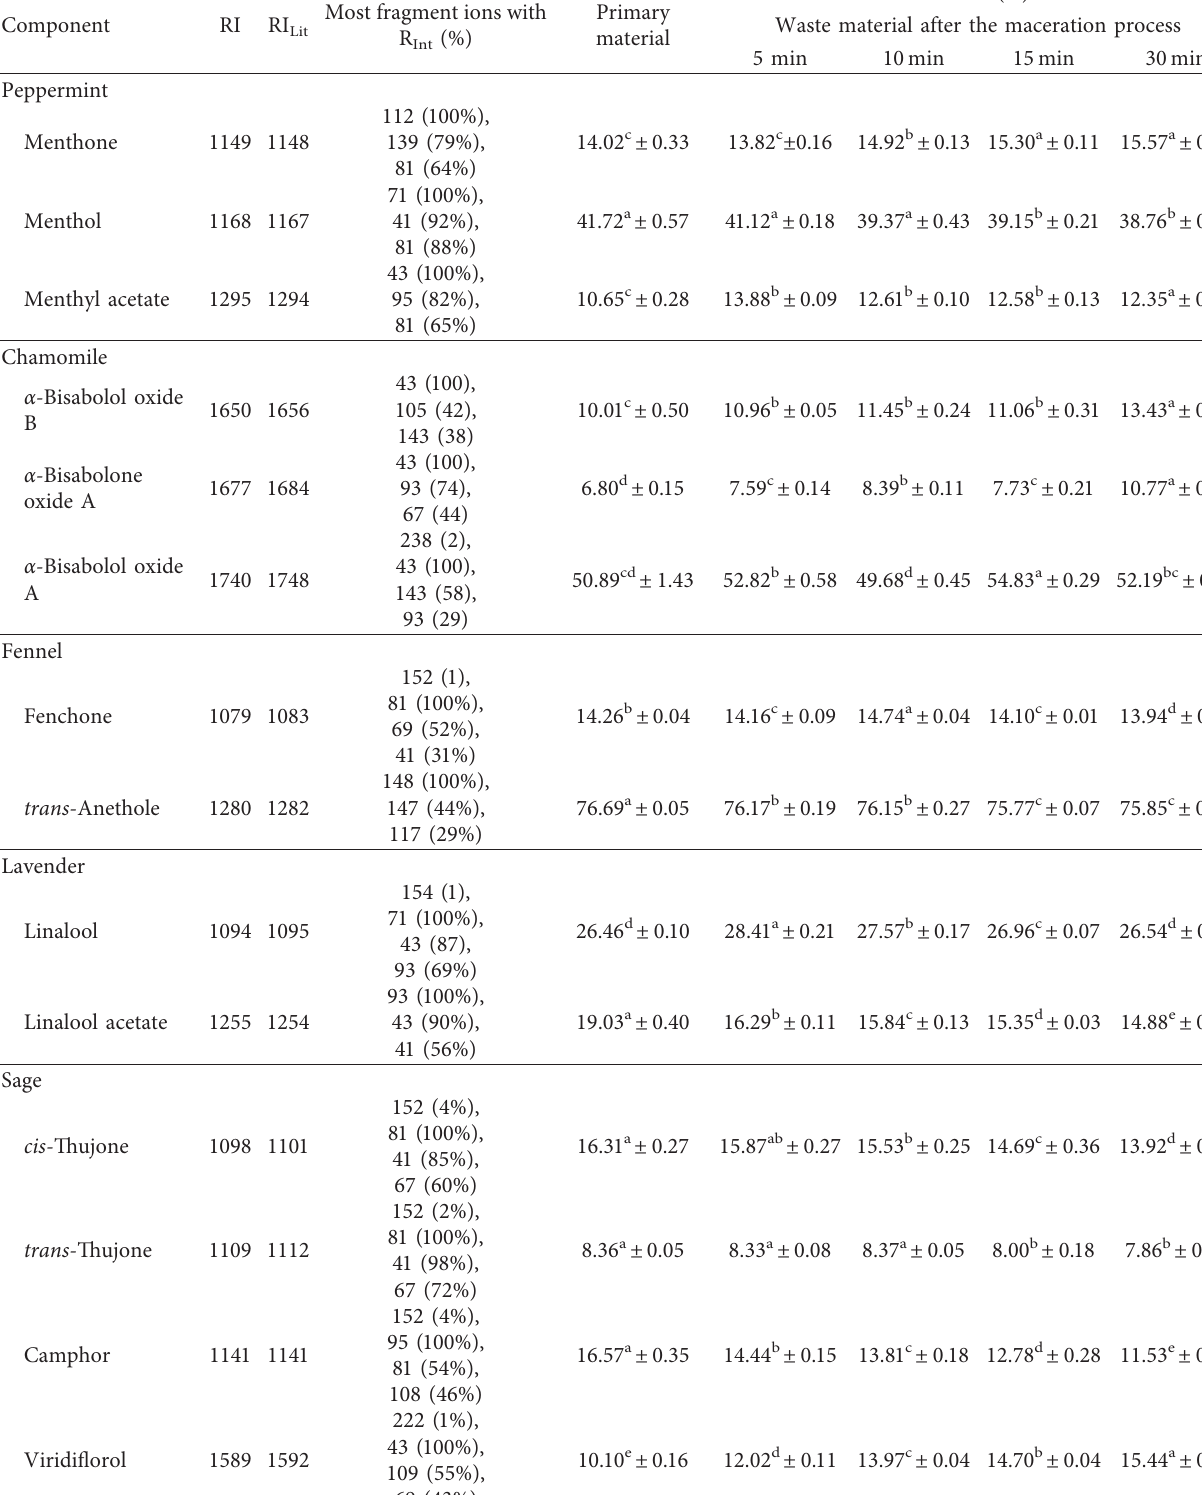
Table 1: Comparison of the content of dominant components in essential oils acquired from the primary and waste plant material.